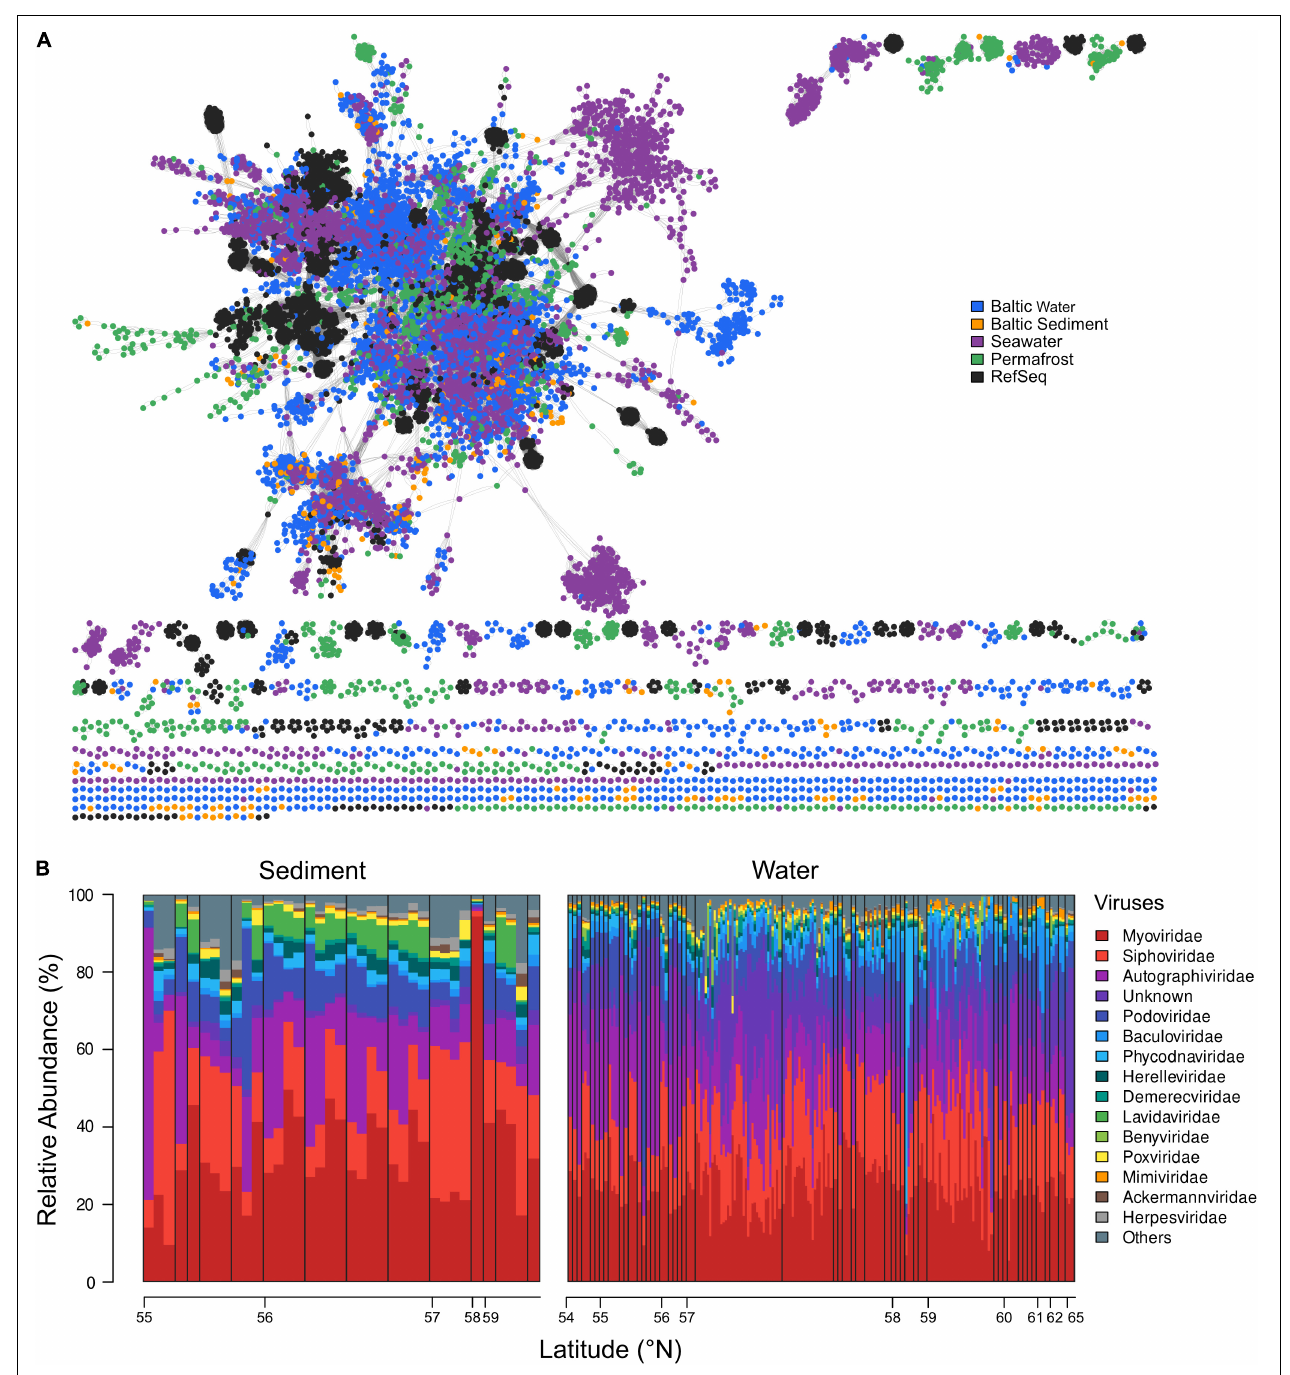
FIGURE 2 | (A) Gene-sharing network of viral sequence space based upon assembled viral genomes from Baltic Sea sediment and water column, GOV seawater, permafrost, and viral RefSeq genomes. (B) Relative abundance (%) and distribution of the top 15 most abundant virus families, ordered in a south-northerly arrangement by latitude ( ◦ N). Viral families are plotted in an increasing order across all water and sediment stations. The remaining families are summarized in “Others.” Black bars delimit depth profiles and are ordered by increasing sediment or water depth, respectively.